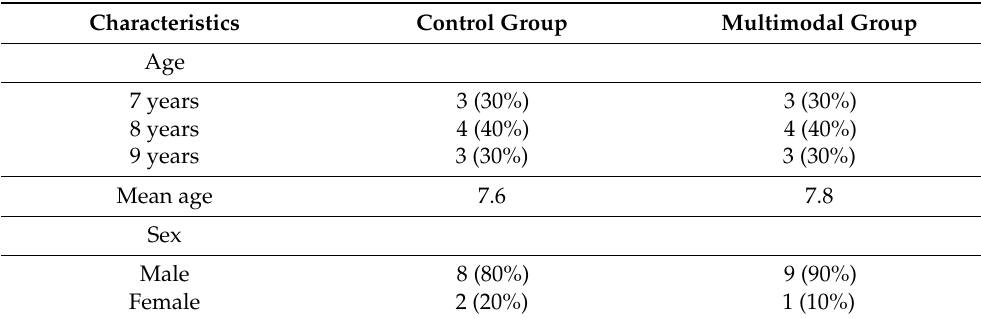
Table 1. Sociodemographic characteristics of the sample of children with